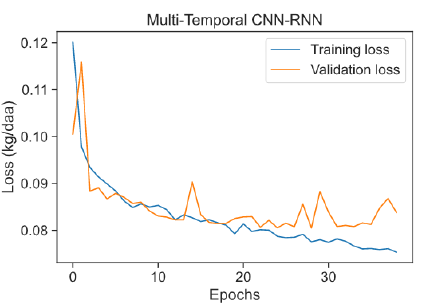
Figure 11. Training and validation loss for the multi-temporal CNN–RNN